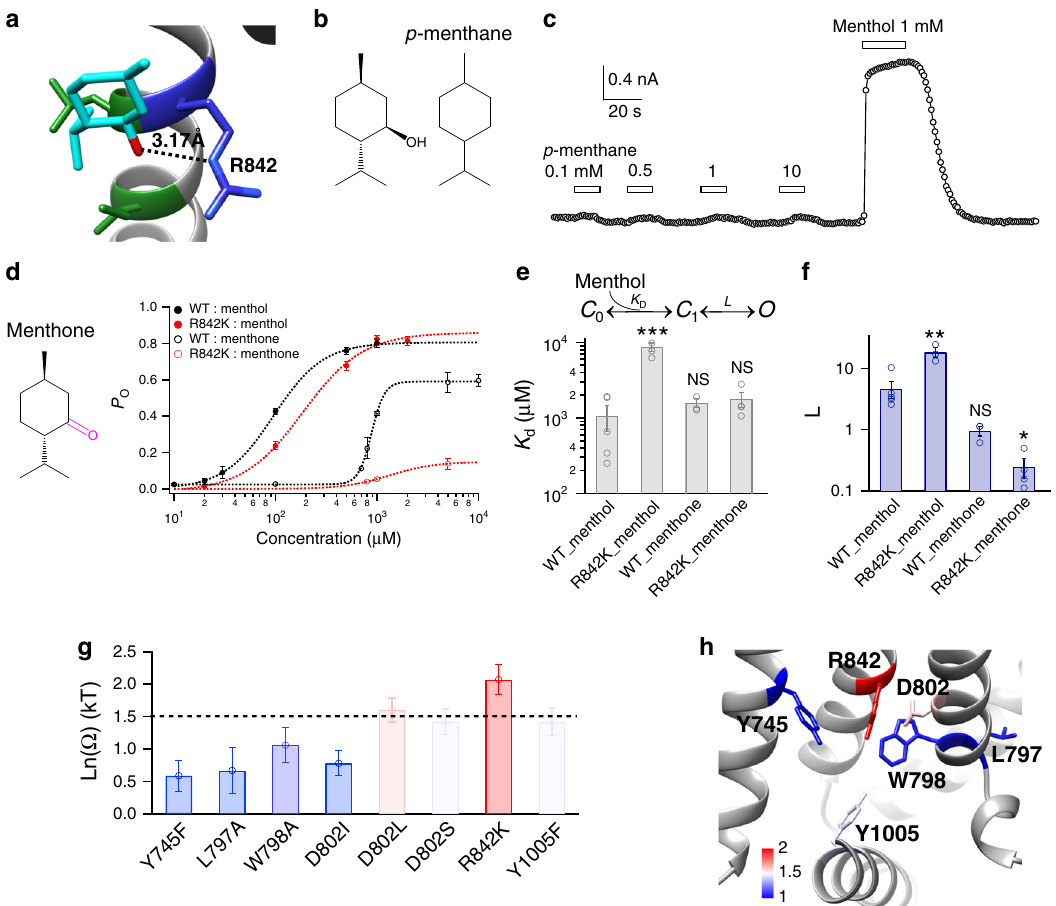
Fig. 2 A speci fi c interaction between menthol hydroxyl hand and the channel. a Docking predicted that there is a hydrogen bond between the hydroxyl hand of menthol and the sidechain of R842 (dashed line in black). b Chemical structures of menthol and p -menthane. c Representative whole-cell patch- clamp recording showed that p -menthane lacking the hydroxyl hand up to 10 mM cannot activate TRPM8 channel. d Chemical structure of menthone, which was used in thermodynamic mutant cycle analysis. The concentration – response curves of wild type and mutant such as R842 with either menthol or menthone were measured with whole-cell patch-clamp recordings ( n = 3 – 5). e , f The general gating scheme where the ligand binding is represented by K d and the equilibrium constant between the closed and open states upon ligand binding is L . For wild type and R842 channel, K d and L values were calculated from the concentration – response curves in d (two-sided t -test, * p < 0.05; ** p < 0.01; *** p < 0.001; NS, not statistically signi fi cant). g Summary of coupling energy measurements. Coupling energy value was calculated from the K d values. Mutants showing a coupling energy larger than 1.5 kT (dashed line) were colored in red. Those with less energy were colored in different shades of blue. At least four independent trials were performed for each chemical at each concentration. h Spatial distribution of coupling energy values within the menthol-binding pocket. Color scheme is the same as in g . Color scale is in the unit of kT. All statistical data are given as mean ± s.e.m. Source data are provided as a Source Data fi